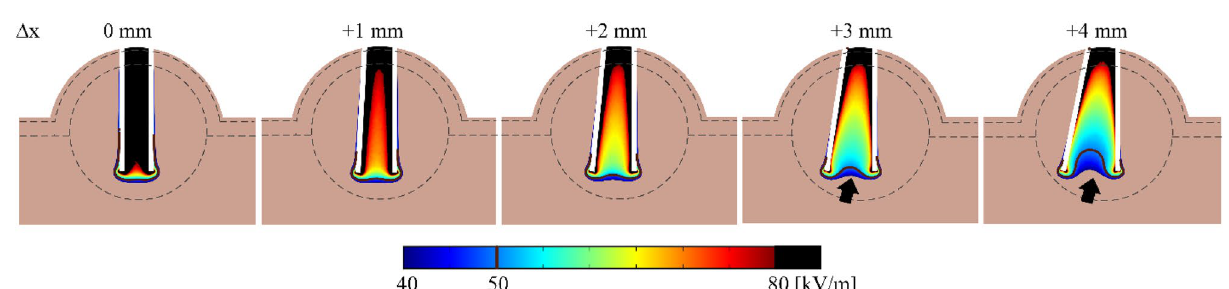
Figure 4. Electric field distribution in tumor tissue case study in + Δx. In the range of 50 kV/m, the indentation (non-electroporated volume between the electrode pairs) was observed from Δx = + 3 mm. The electric field of 50 kV/m is a typical reversible electroporation threshold. The cut planes were generated by COMSOL Multiphysics v.5.1 (COMSOL Inc., Stockholm, Sweden; https:// www. comsol. com/ comsol- multi physi